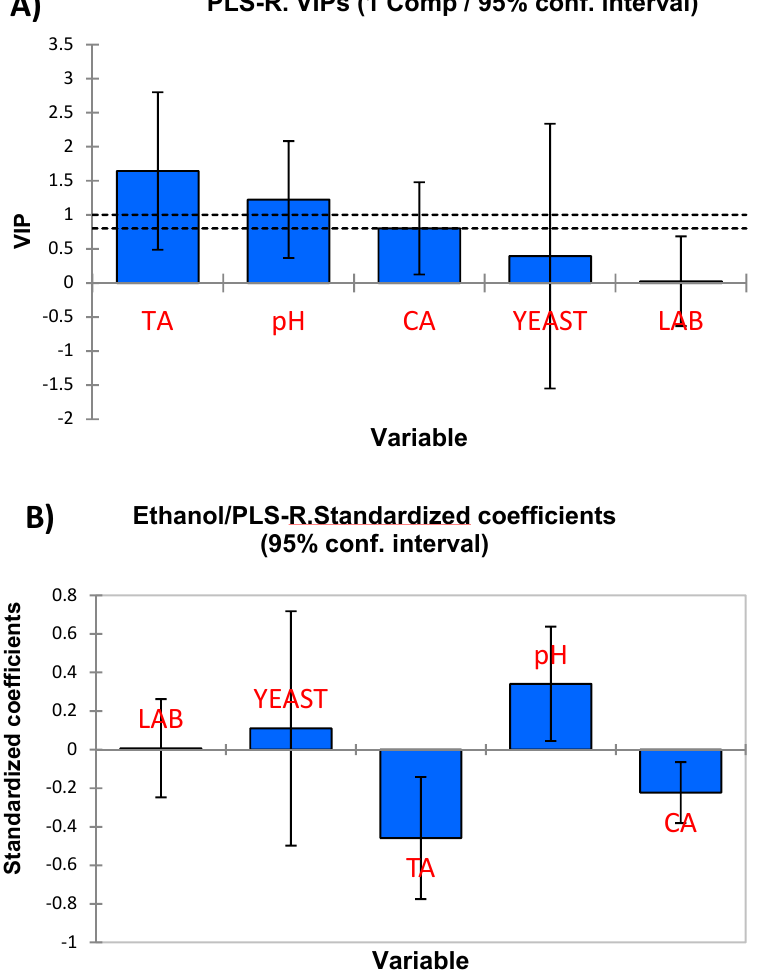
Figure 2. PLS-R analysis, using final physicochemical and microbiological characteristics as independent variables and VOCs as dependent. ( A ) Variable importance for the projection and ( B ) Significant standardised coefficients for the presence of ethanol.